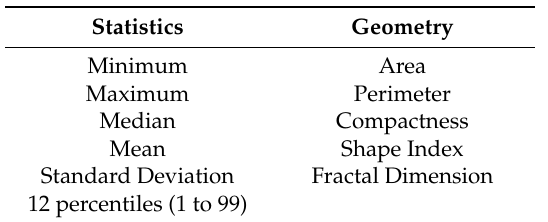
Table 6. Computed statistical and geometrical variables calculated for each image object. The seventeen statistical variables were calculated per input layer (175) whereas only one set of (five) geometrical variables was